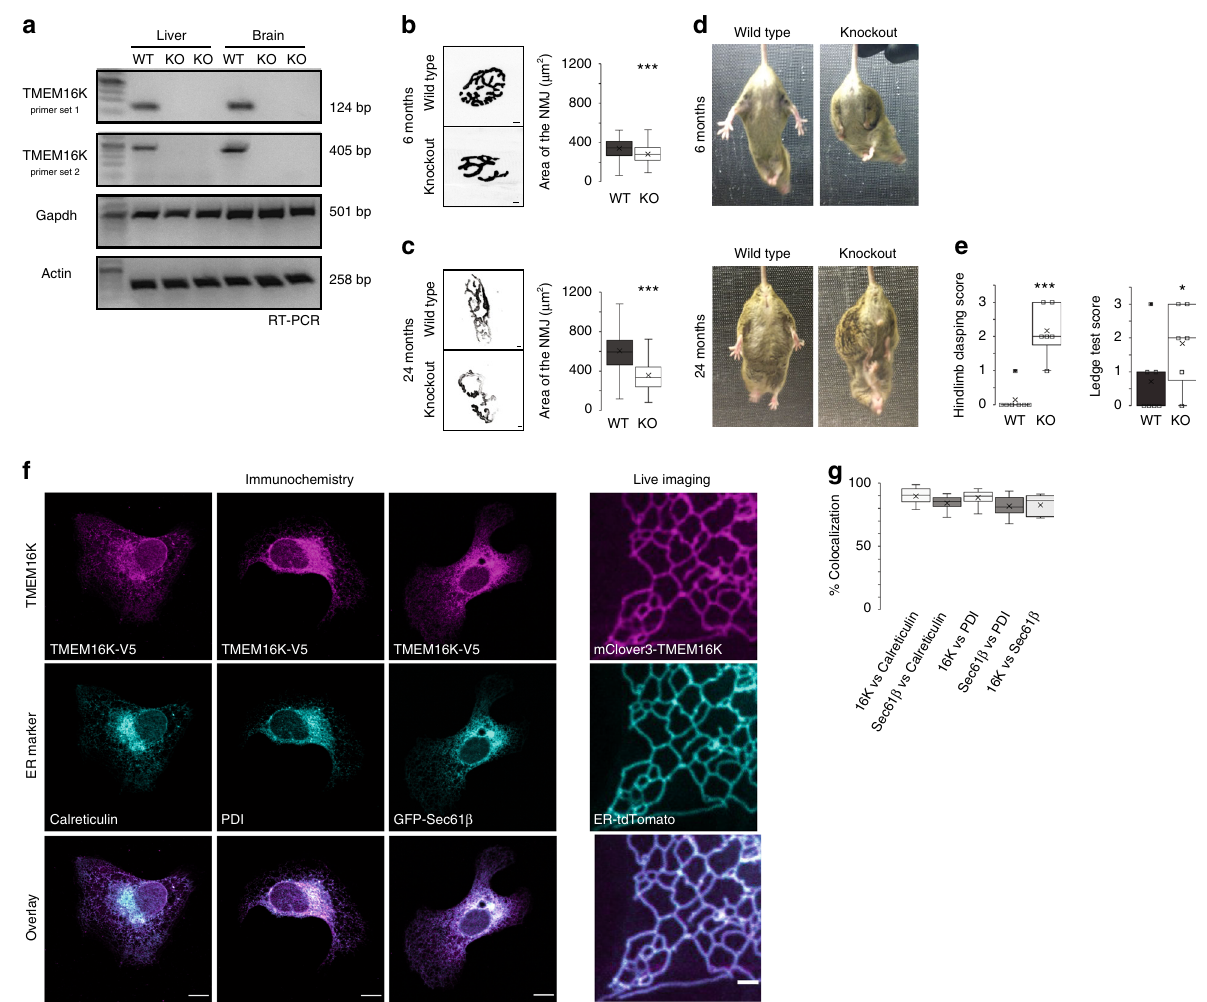
Fig. 1 TMEM16K knockout mice. a RT-PCR from liver and brain tissues obtained from the wild type and TMEM16K full knockout mice. Two different sets of primers amplifying TMEM16K were used, and Gadph and β -actin were ampli fi ed as controls. b Representative images and quanti fi cation of neuromuscular junction (NMJ) at 6 months of age from wild type ( n = 133 NMJ, three animals) and TMEM16K full KO ( n = 132 NMJ, four animals) littermates visualized with the fl uorescently labeled α -Bungarotoxin. Scale bar 5 µ m, Single factor ANOVA, p value = 2.10E − 06*** c Representative images and quanti fi cation of neuromuscular junction at 24 months of age from WT ( n = 137 NMJ, fi ve animals) and TMEM16K full KO ( n = 126 NMJ, four animals) littermates. Scale bar 5 µ m, Single factor ANOVA, p value = 1.31E − 22*** d Representative images of hindlimb clasping, of WT and TMEM16K full KO littermates at 6 and 24 months of age. e Quanti fi cation of hindlimb clasping ( p value = 0.00003***) and ledge walking ( p value = 0.05*) at 24 months of age of neuron speci fi c TMEM16K KO ( n = 6 animals) and their WT ( n = 7 animals) mice. One-tailed t -test. See Supplementary Movie 1. f Columns 1 – 3: Immunocytochemistry of U-2OS cells transfected with TMEM16K tagged with V5 epitope and stained for ER-markers Calreticulin, Protein Disul fi